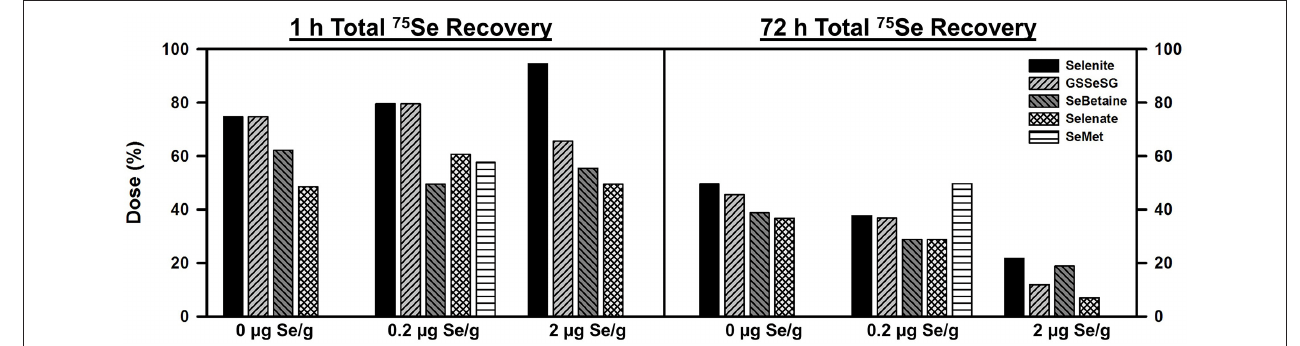
FIGURE 1 | Total 75 Se recovery at 1 and 72h after injection 75 Se selenocompounds. Rats were fed the indicated dietary Se levels as selenite for 50–80 d, injected iv with 50 µ Ci of tracer 75 Se-labeled Selenite, GSSeSG, SeBetaine, Selenate, or SeMet, killed at 1 and 72h afer dosing, and 75 Se retained in blood, liver, kidney, heart, testes, epididymus, and muscle was counted. Values are the percent of the administered 75 Se dose recovered ( n = 1 per treatment at each time for each selenocompound, n = 26 total).